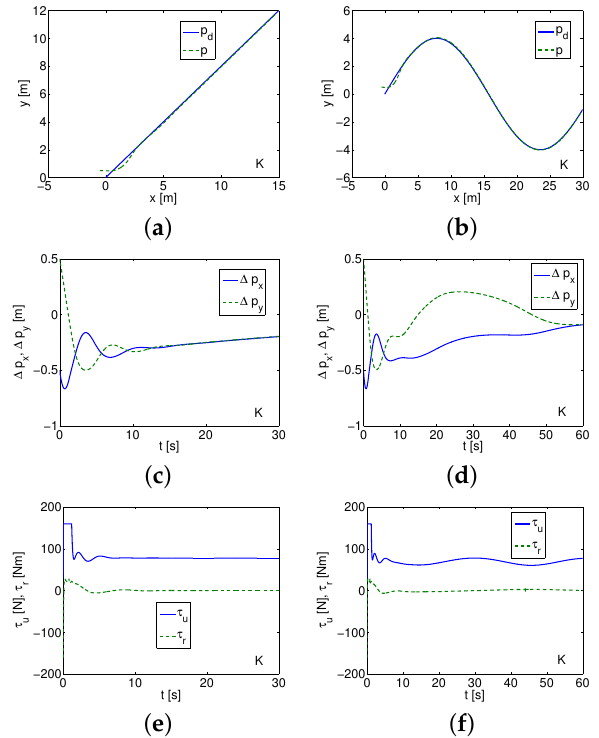
Figure 10. Simulation results for Kambara (fast TSMC (FTSMC))—linear and sine trajectory. ( a , b ) Desired and realized trajectory; ( c , d ) position errors; ( e , f ) applied forces/torques.